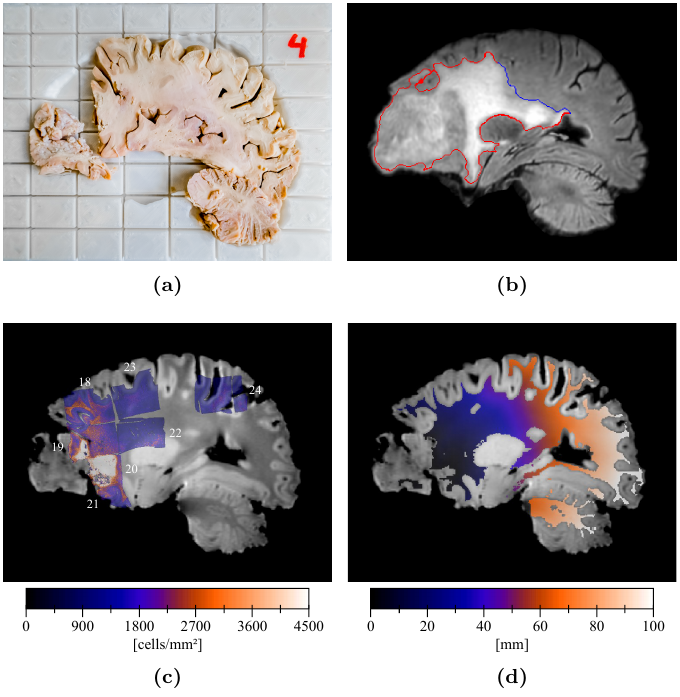
Figure 3. Cell density profile analysis. ( a ) Brain slice inside its 3D-printed cutting guide. ( b ) Cor- responding slice of the registered in vivo T2-FLAIR image with segmented edema outlines. The blue and red segments of the outline respectively correspond to free and non-free to diffuse parts of the edema boundary (see Section 4). ( c ) Corresponding slice of the ex vivo T1 image (grayscale) and superimposed registered cell density maps (colored) with their slide number (see Table A1). ( d ) Corresponding slice of the geodesic distance map to the tumor core across white matter.